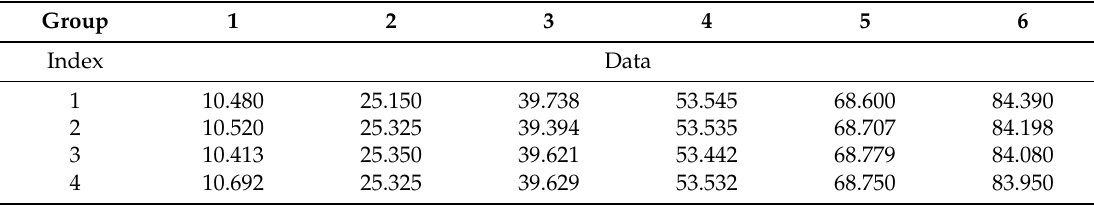
Table 2. Data and statistics of precision test Groups 1–6.